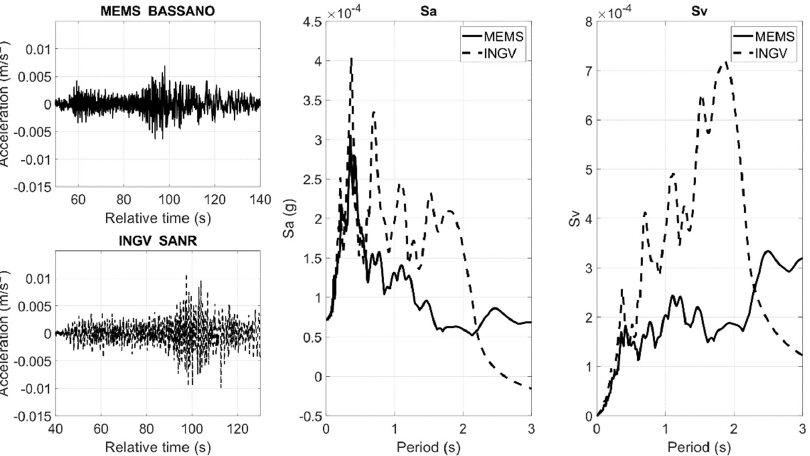
Figure 6. Comparison of the ASX1000 MEMS sensor prototype, BASSANO, and the high-quality sensors, SANR, belonging to the INGV networks. The comparison is made in terms of waveforms, normalized Sa, and Sv.